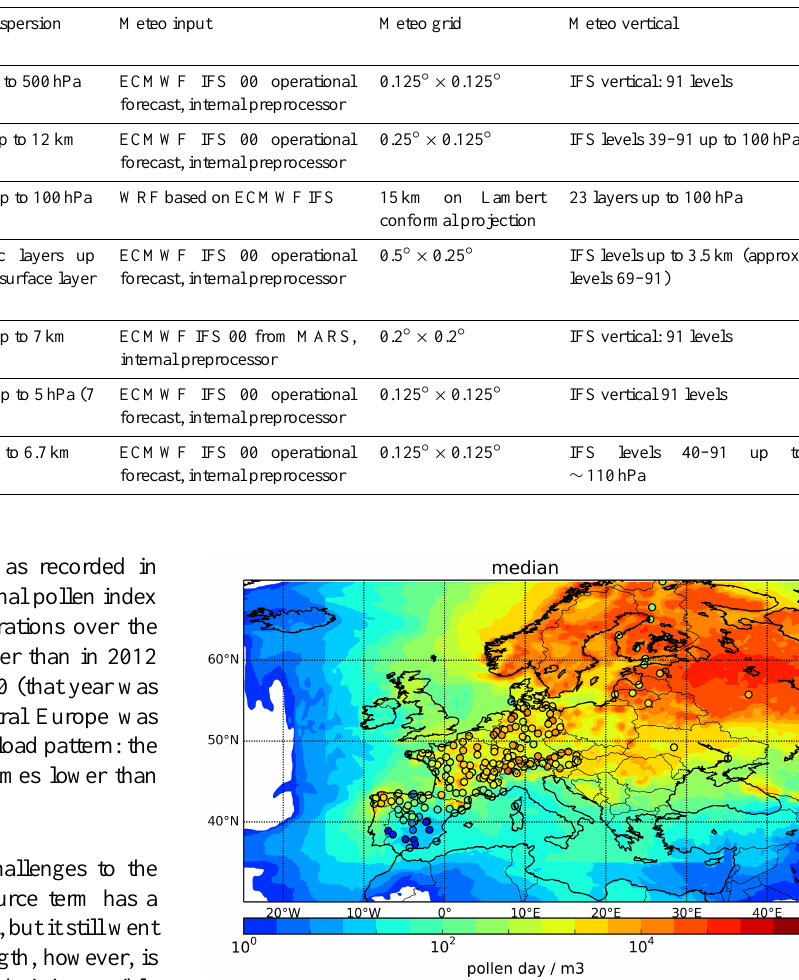
Figure 2. Comparison of SPI for the ensemble median with the ob- served pollen load (pollendaym − 3